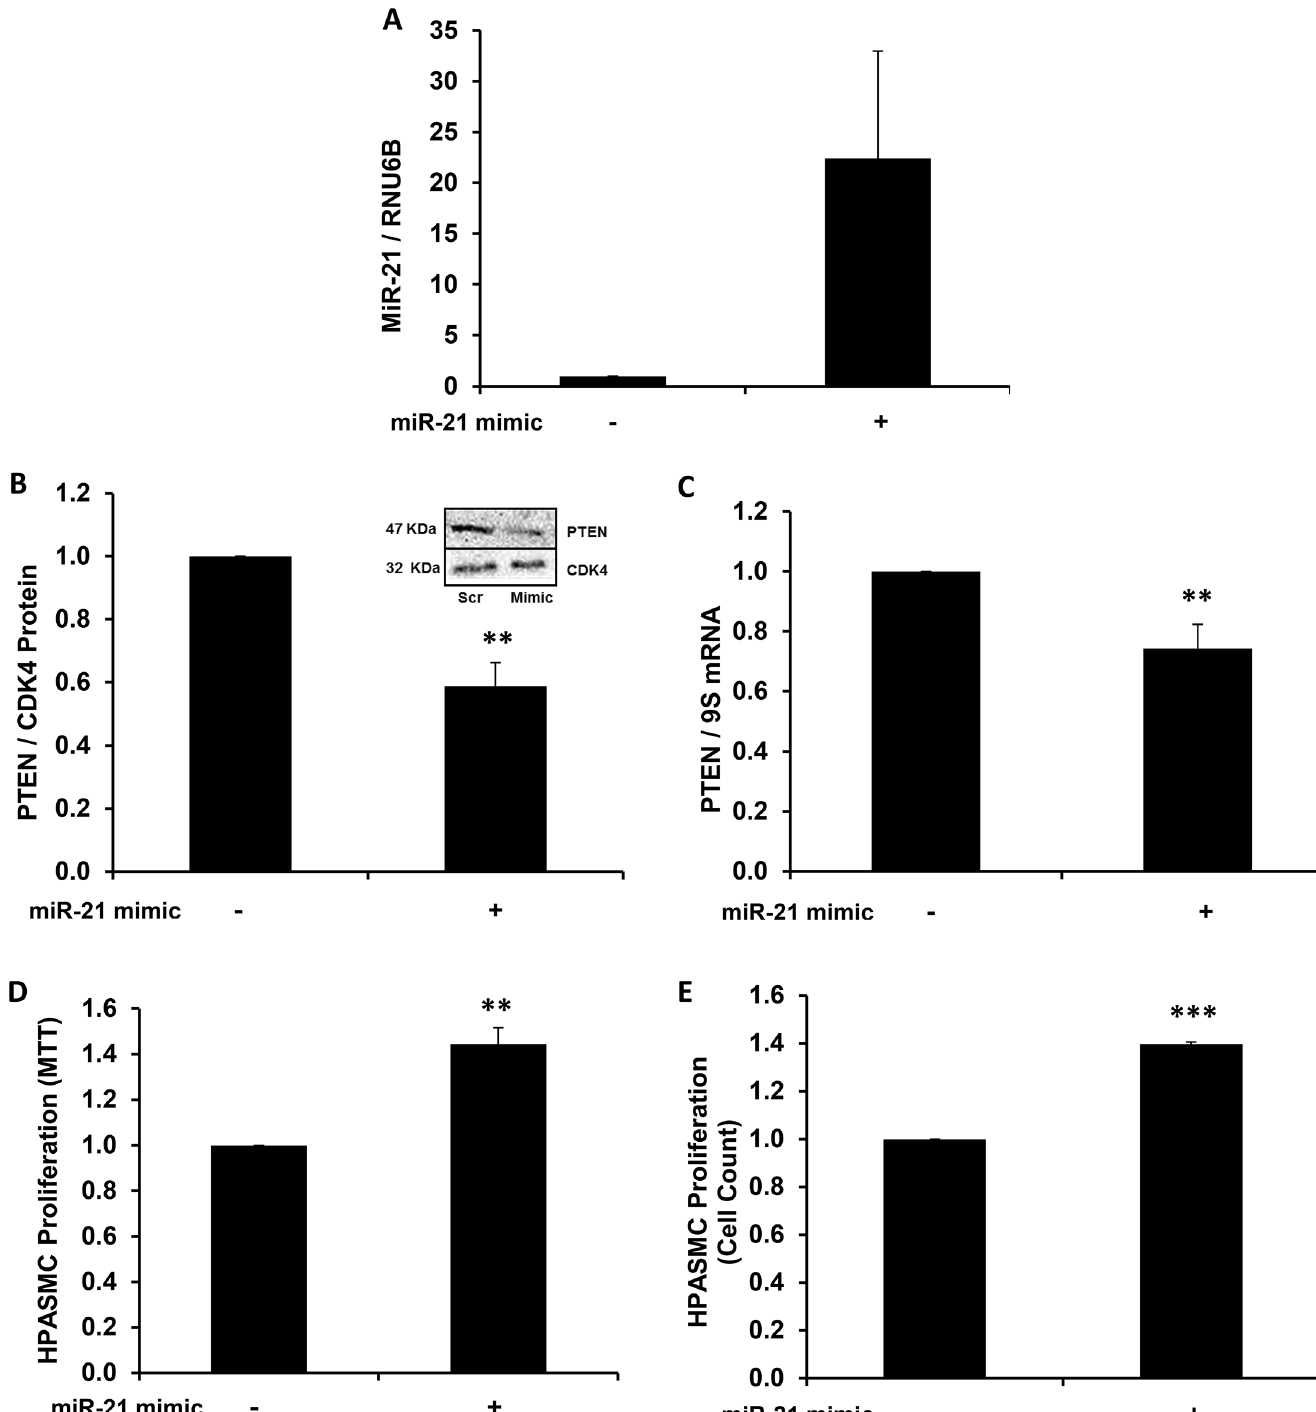
Fig 3. MiR-21 overexpression reduces PTEN levels and enhances normoxic HPASMC proliferation. (A-C) HPASMC were transfected with mature miR-21 mimic, and PTEN expression was analyzed. A representative immunoblot is shown in panel B. After transfection, HPASMC proliferation was measured by (D) MTT assay and (E) manual cell counting. Each bar represents mean ± SEM (A) miR-21 levels (B) PTEN protein, (C) PTEN mRNA, (D, E) proliferation. ** P < 0.01 vs Scrambled, *** P < 0.001 vs Scrambled. A,B,D,E. (n = 3 – 4); C. (n = 7).